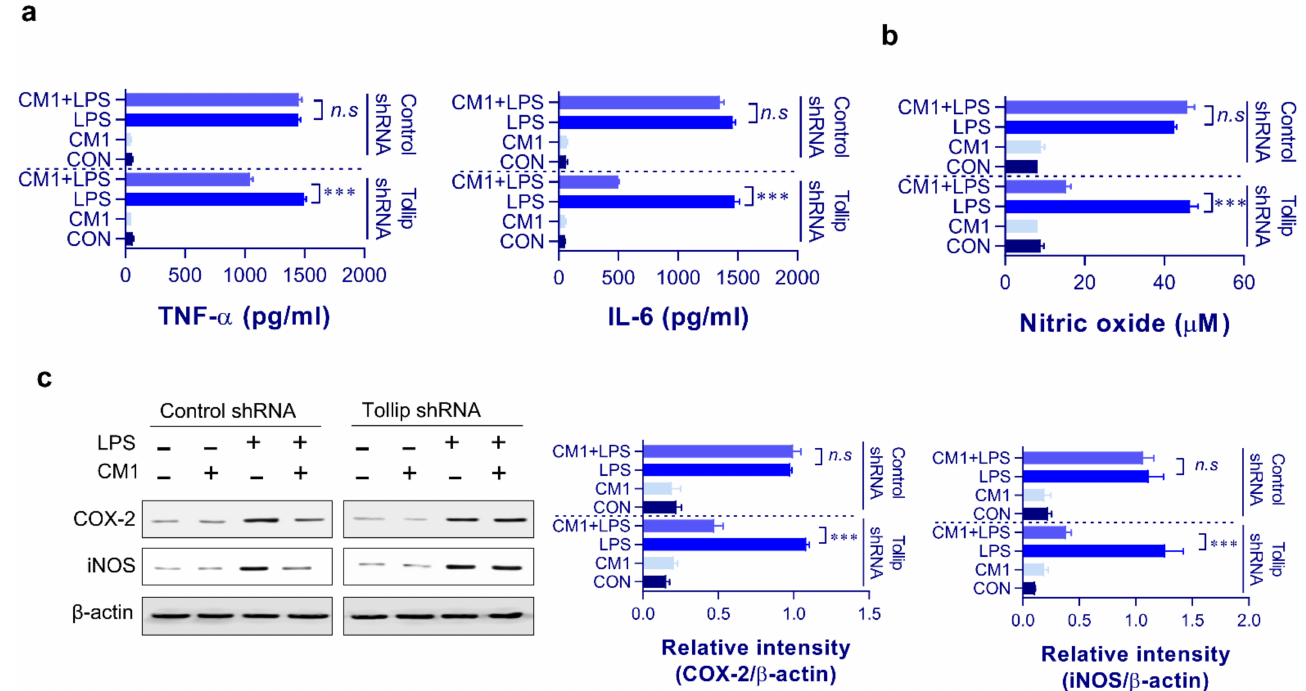
Figure 4. Tollip is indispensable for the inhibitory action of CM1 on proinflammatory mediators in LPS-treated RAW264.7 cells. Control and Tollip shRNA-transfected RAW264.7 cells were incubated with CM1 (2 µ g/mL) for 1 h and then treated with LPS (200 ng/mL) for 24 h. TNF- α and IL-6 levels in the culture medium were measured by ELISA ( a ). RAW264.7 cells were pretreated with CM1 (2 µ g/mL) for 1 h and then stimulated with LPS (200 ng/mL) for 45 min. NO level in the culture medium was measured using the Griess assay ( b ); *** p < 0.001. Data are presented as the mean ± SD for triplicate determinations of one representative plot among three independent experiments. Cytosolic fractions were analyzed to determine the COX-2 and iNOS protein levels using specific Abs ( c ). One representative blot from among three independent experiments is shown. Statistical analysis was performed by one-way ANOVA in conjunction with Tukey’s multiple test; n.s : no significance and *** p < 0.001. Abbreviations: Tollip, Toll-interacting protein; LPS, lipopolysaccharide; shRNA, short hairpin RNA; TNF, tumor necrosis factor; IL, interleukin; NO, nitric oxide; COX-2, cyclooxygenase-2; iNOS, inducible NO synthase; p-p38, phosphor-p38; p-JNK, phosphor-c-Jun N-terminal kinase; I κ B, inhibitor of κ B; p-I κ B, phosphor-I κ B; Abs, antibodies; NF, nuclear